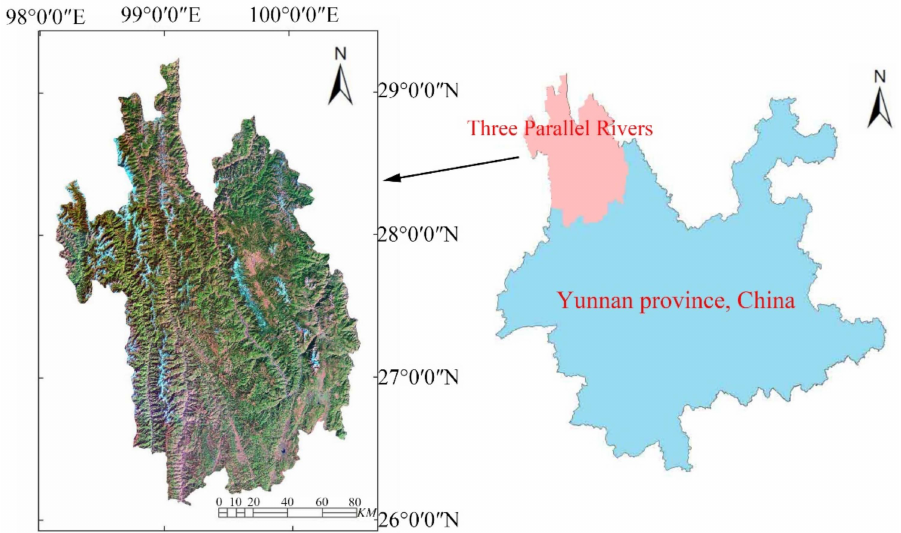
Figure 4. Three Parallel Rivers area location.